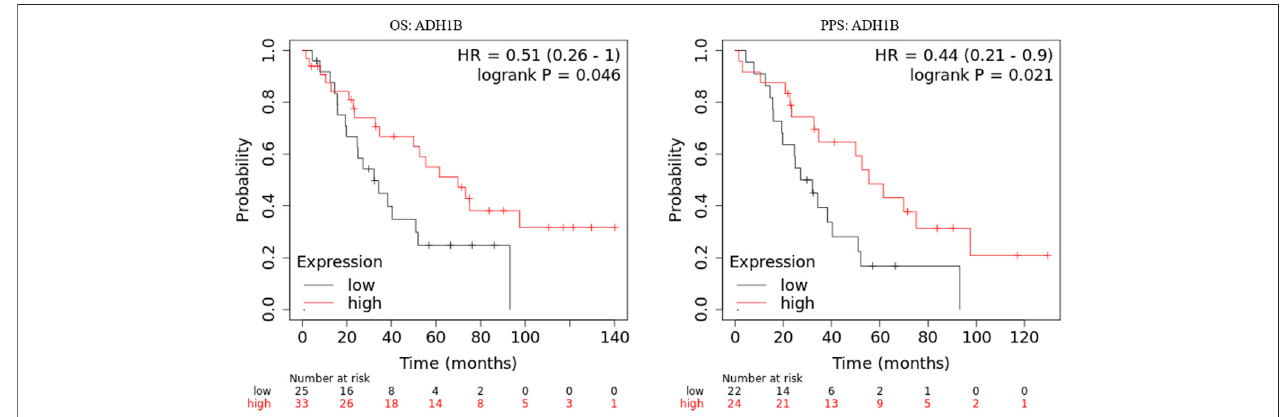
FIGURE2| Kaplan-Meiercurves ofADH1B inGSE30161. Kaplan-Meier plotterdatabase wasapplied toobtaintheOSand PPScurves ofADH1B inpatientswith ovarian cancer.